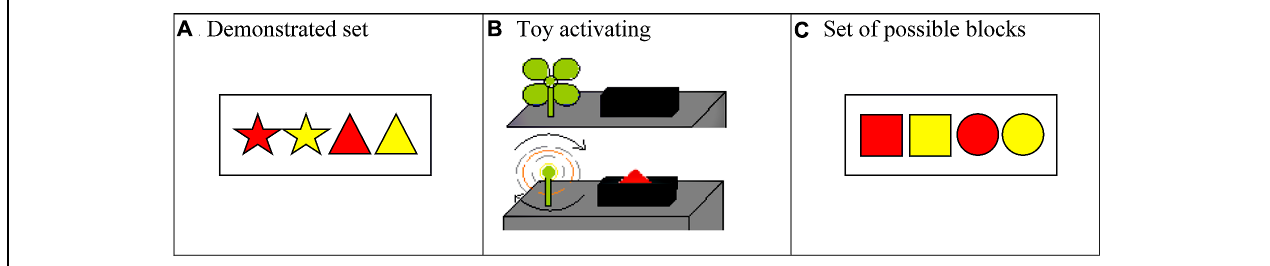
FIGURE 1 | (A) Set of four blocks used to demonstrate that all blocks make the toy go. (B) The novel toy pictured in the off position and the on position. (C) Participants were asked to select two blocks, from this set of four possible blocks, to show Daisy so that she can infer the rule specified by the child’s